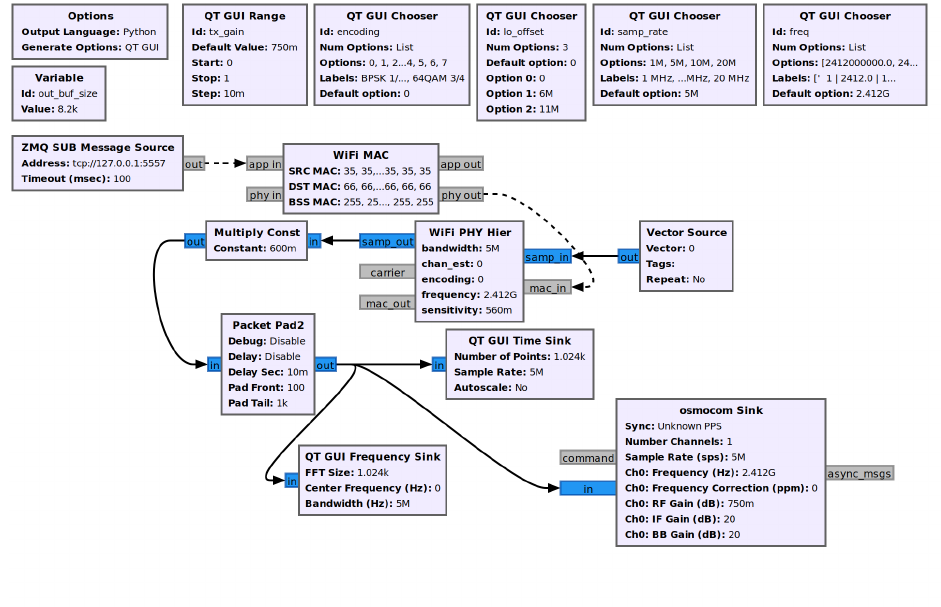
Figure 10. GNU Radio transmitter program flowchart for 802.11p. The messages are received through a ZMQ PUB-SUB communication, and the resulting 802.11p message is sent over the HackRF One using the osmocom sink.